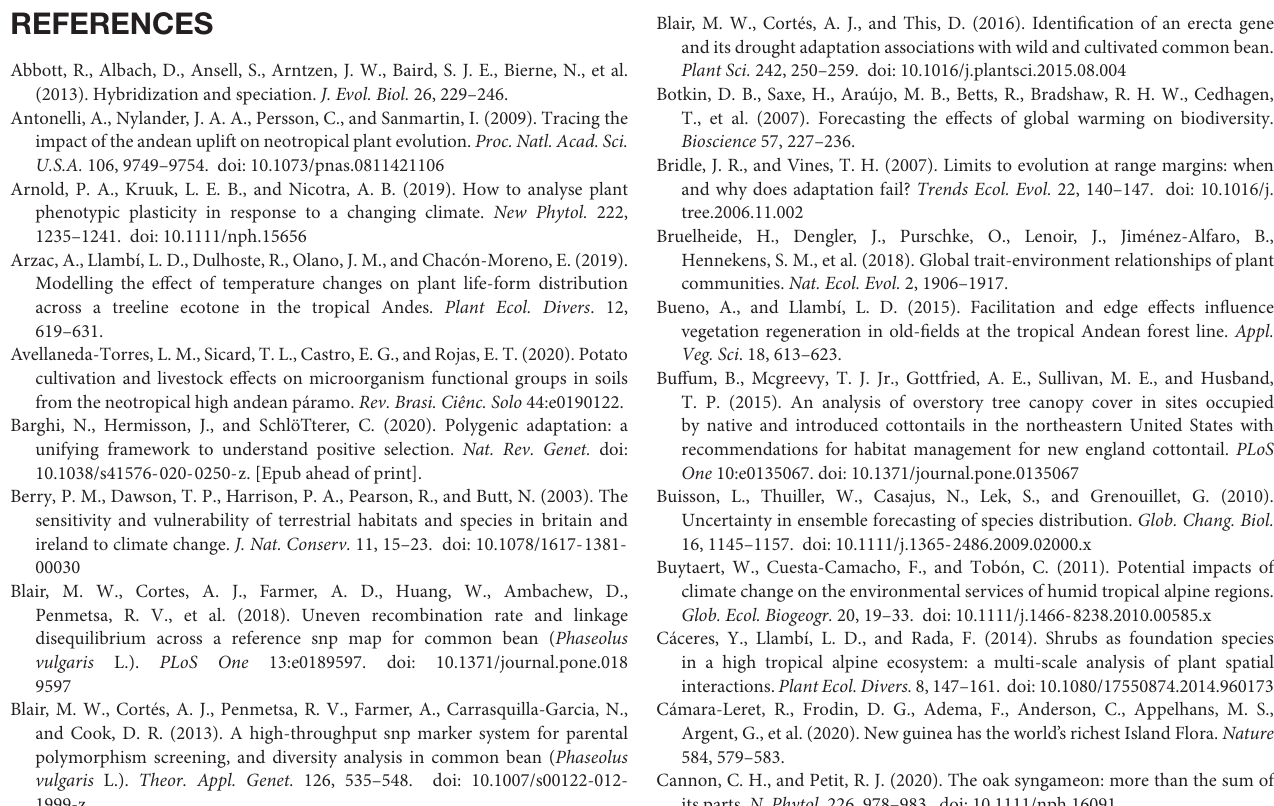
Van Proosdij et al. (2016) for narrow-ranged species). Espeletia taxonomy follows Cuatrecasas (2013). Supplementary Table 2 | Number of records for each of the 28 Espeletia taxa across Páramo sky islands in the Colombian Andes, and altitudinal range for each taxon. Number of records, number of Páramo complexes spanned, and minimum and maximum altitudes for each taxon are gathered from Supplementary Table S1 . Supplementary Table 3 | Variance Inflation Factor (VIF) for five non-collinear (VIF < 10) WorldClim bioclimatic variables considered for modeling at a 30 s (1 km 2 ) spatial resolution for the current and future scenarios, besides a Digital Elevation Model (DEM). Absolute r -values ranged from 0.05 (BIO18 ∼ DEM) to 0.65 (BIO15 ∼ BIO18). Supplementary Table 4 | Current model validation based on average Area Under the ROC Curve (AUC) and porcentual contribution of the six non-collinear environmental variables for each of the 28 Espeletia taxa. AUC in the training and testing datasets are an aggregate measure of performance across all possible classification thresholds. Pseudo-absences (number of background points) are also averaged for each of the 28 putative taxa. Un-averaged statistics are kept in Supplementary Table S5 . The six non-collinear variables included five WorldClim bioclimatic variables at a 30 s (1 m 2 ) spatial resolution. Environmental variables ( Supplementary Table S3 ) are abbreviated as follows: (BIO2) Mean Diurnal Range, (BIO4) Temperature Seasonality, (BIO15) Precipitation Seasonality, (BIO18) Precipitation of Warmest Quarter, (BIO19) Precipitation of Coldest Quarter, and (DEM) Digital Elevation Model. Supplementary Table 5 | Current model validation based on Area Under the ROC Curve (AUC) and relative contribution of the six non-collinear environmental variables for each of the 10 runs in the 28 Espeletia taxa. The following overall summary statistics are kept: optimum training subset, regularized training gains, un-regularized training gains, effective iterations, training AUC, optimum testing